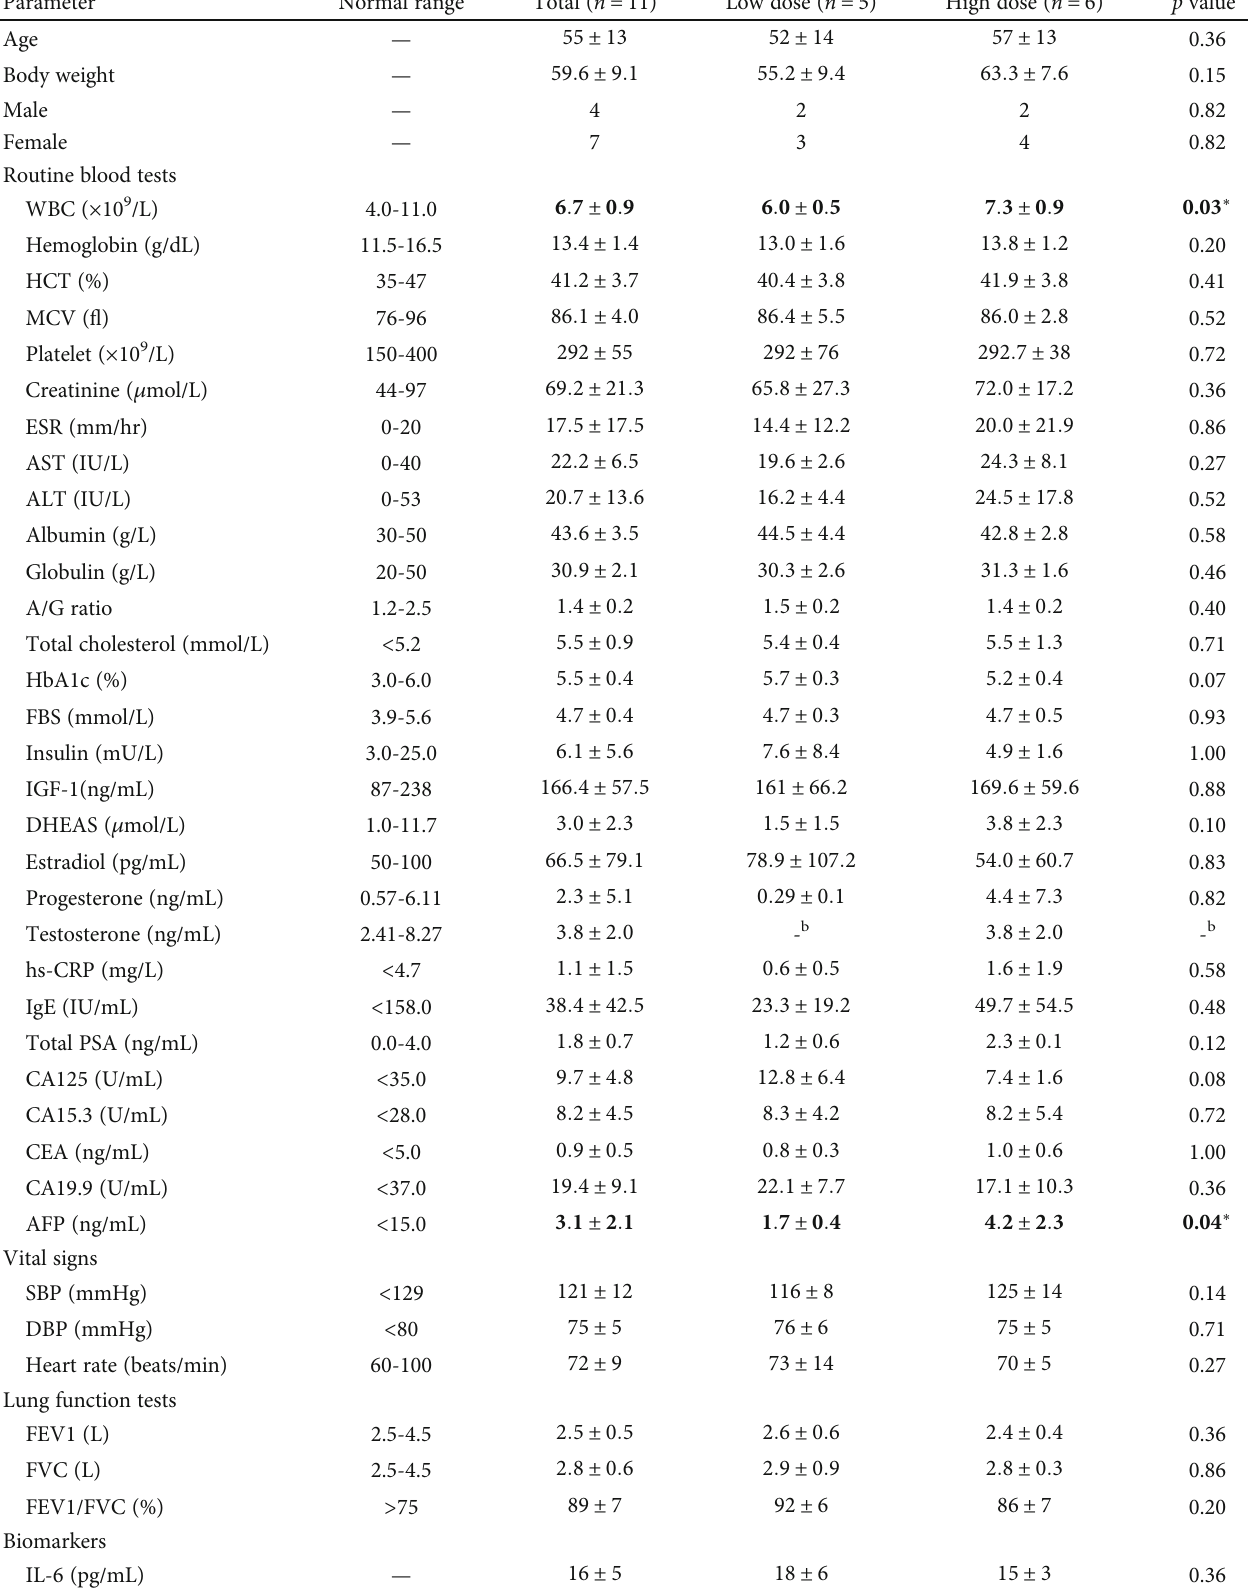
Table 2: Clinical characteristics in recruited subjects during baseline